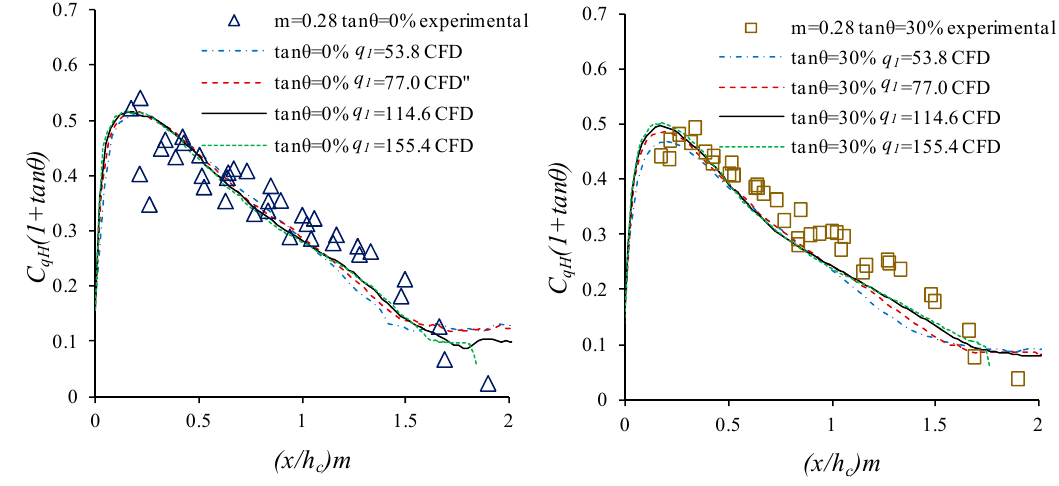
Figure 16. Discharge coefficient, C qH , calculated from Equation (1) with the energy head measured and the sine of the angle of velocity vector in the slit between two bars simulated with CFD.